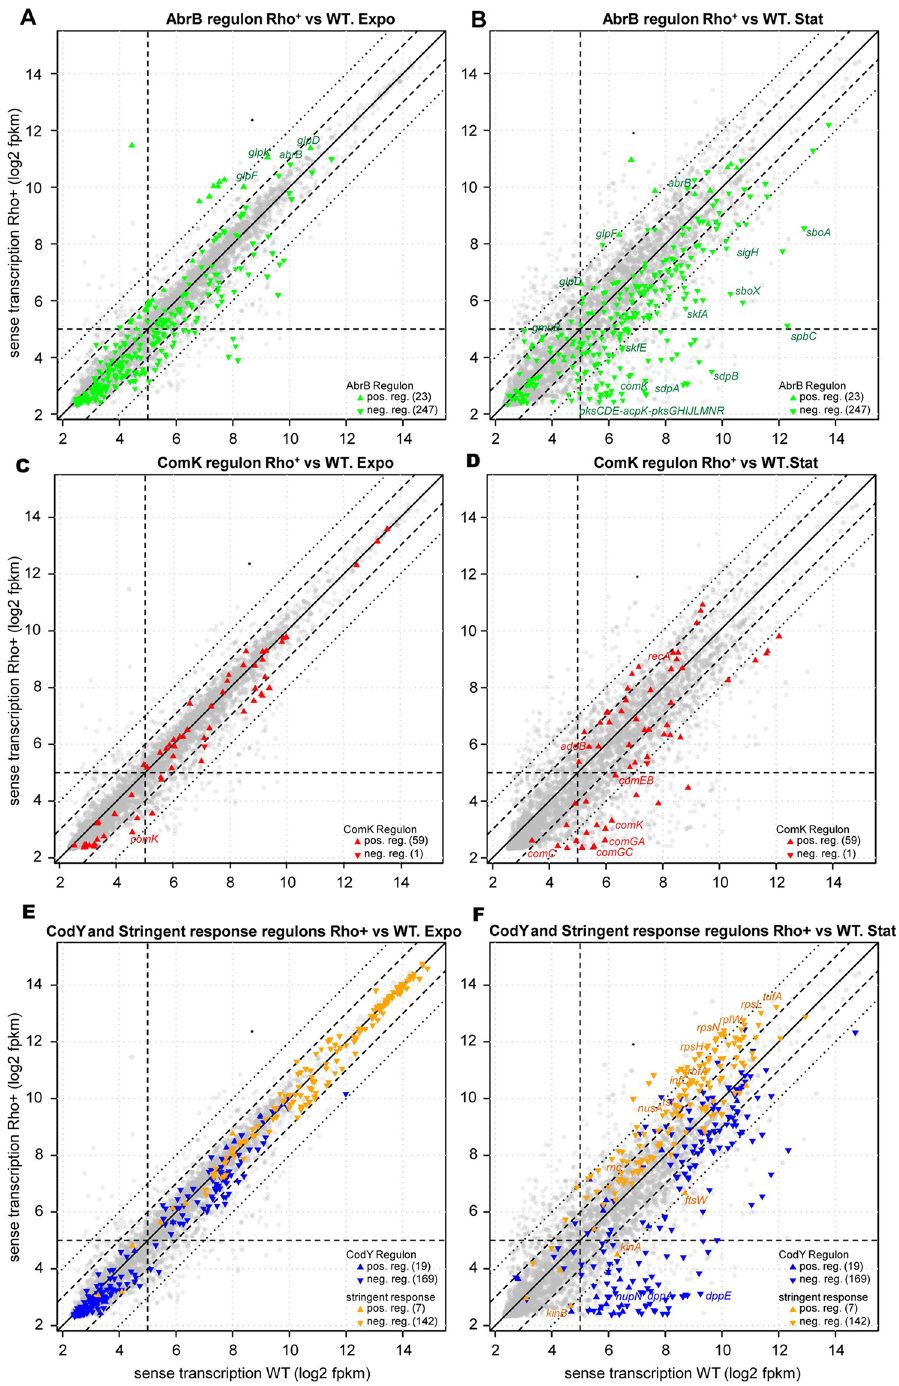
Fig 6. Differential expression of the AbrB, ComK, CodY and stringent response regulons in the Rho + strain across exponential growth and stationary phase. Scatter plots display the expression values for the each gene from the AbrB regulon (A and B), ComK regulon (C and D), CodY and the stringent response regulon (E and F) by comparing B . subtilis Rho + and WT strains under conditions of exponential growth (A, C, E) and stationary phase (B, D, F). Each symbol represents one of the 4,292 AL009126.3-annotated genes. Colored triangles indicate the genes from AbrB (green), ComK (red), CodY (blue) and the stringent response (orange) regulons, respectively; gray circles represent genes outside of the analyzed regulons. Expression levels of the individual genes in WT and Rho + are represented, respectively, on x- and y-axes by the mean log2(fpkm+5) between biological replicates. Horizontal and vertical